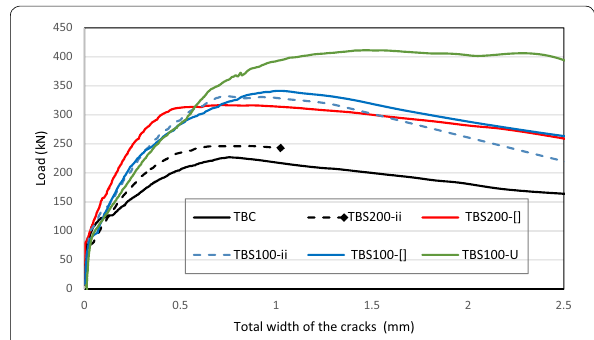
Fig. 15 Load versus the total width of the shear cracks at the same position for the tested